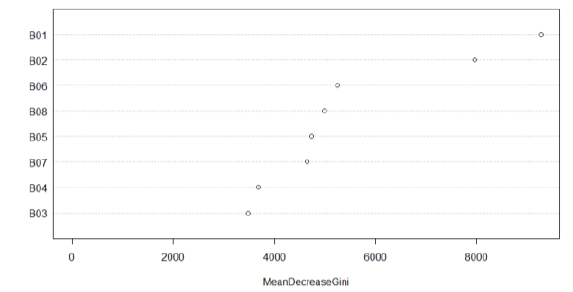
Figure 5. Plot of the Mean Decrease in Gini for each of the WorldView bands used in the prediction. B01: Coastal Blue; B02: Blue; B03: Green; B04: Yellow; B05: Red; B06: Red Edge; B07: NIR1; B08: